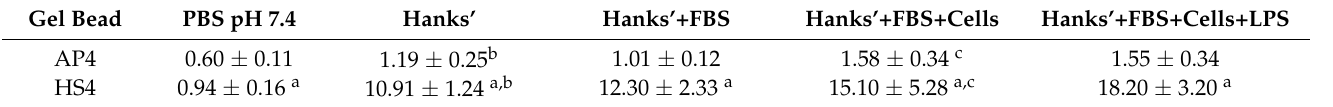
Table 3. The hardness (N) of pectin gel beads after 4 h incubation in different media. Gel Bead